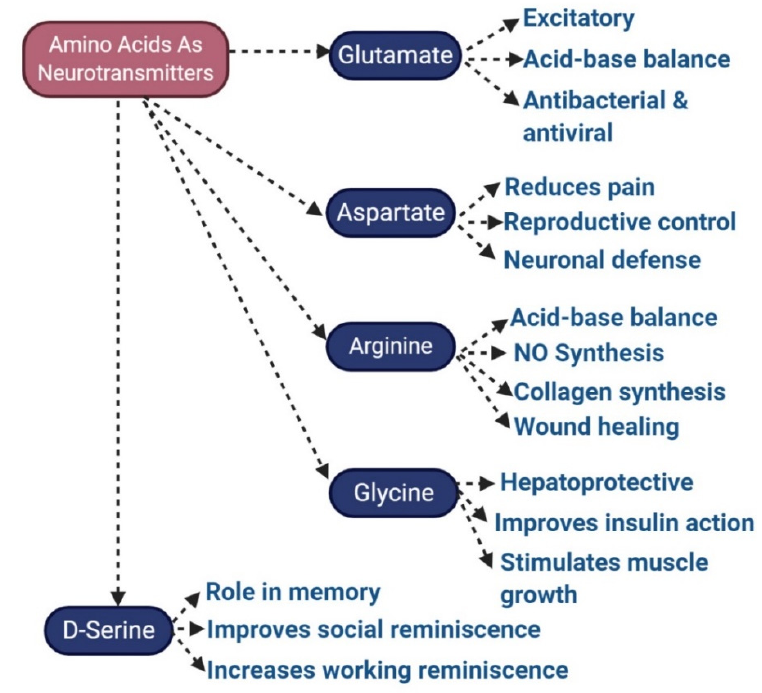
Figure 3. NTs based on amino acids and their major functions.